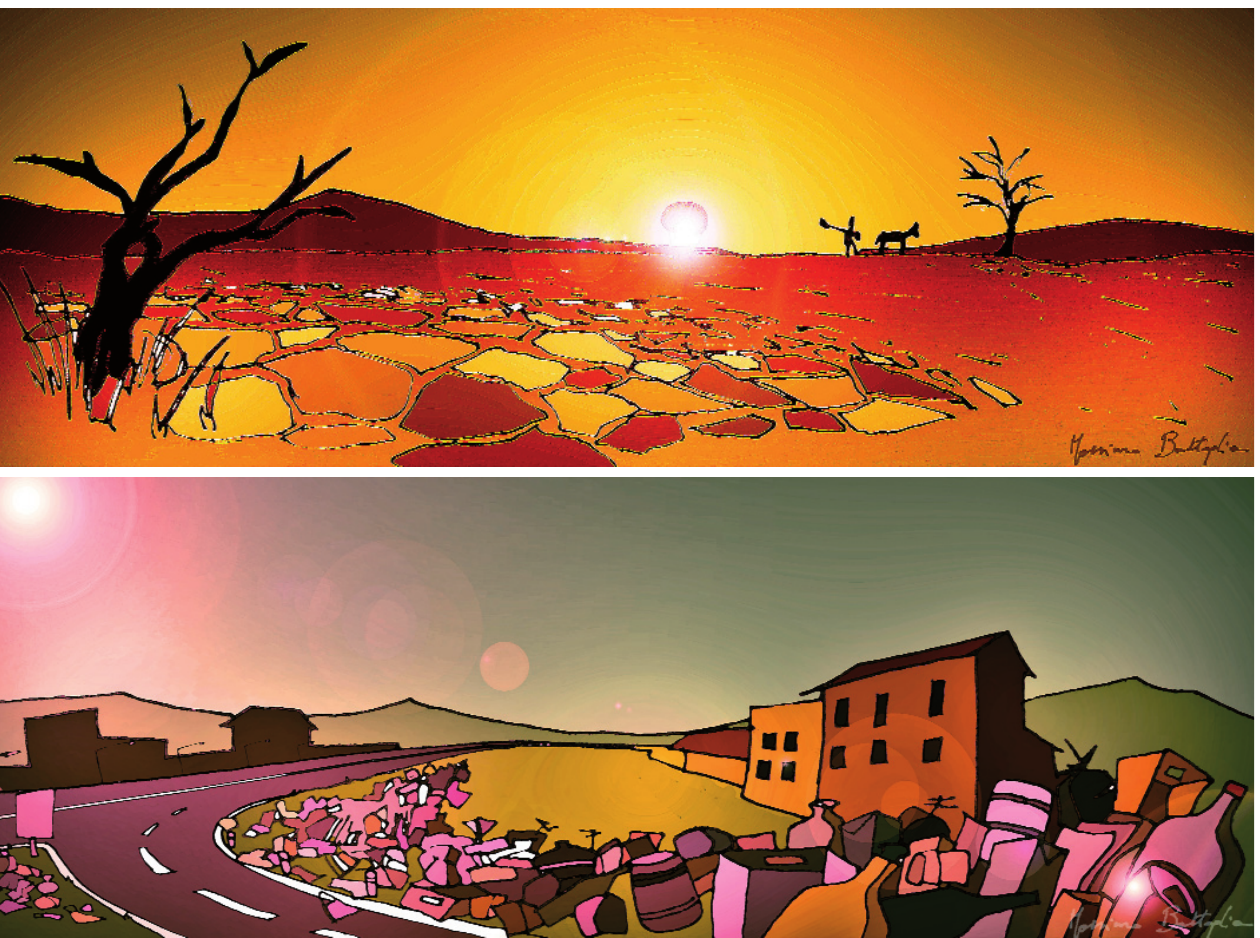
Figure 6. Selected scenes. Top: In all, 95% of students located the drought scene in Cape Verde, suggesting discussions on droughts in Italy and on the implications of global warming. Bottom: The rubbish scene was located in Italy (50%); and also both in Italy and Cape Verde (30%). The results show that rubbish accumulation is perceived as a global problem that is managed in different ways in different